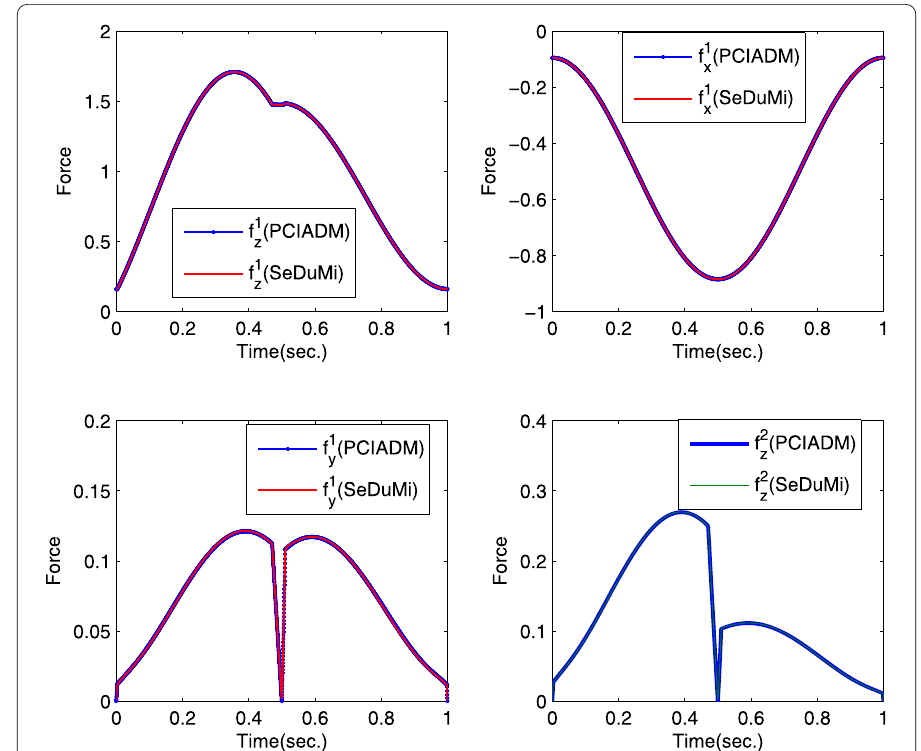
Figure 2 Comparativeresultsofthetwomethods . Figure 2 gives optimal force f 1 z , f 1 x , f 1 y , f 2 z by the two